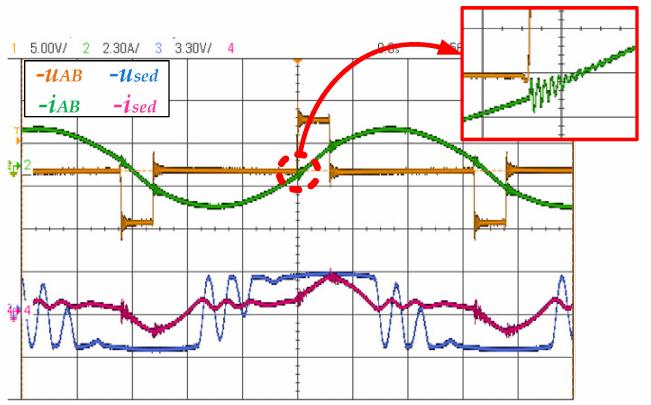
Figure 25. Waveforms of the current and voltage on the primary and secondary sides when the MOSFETs work in soft-switching state with redundant reactive power.